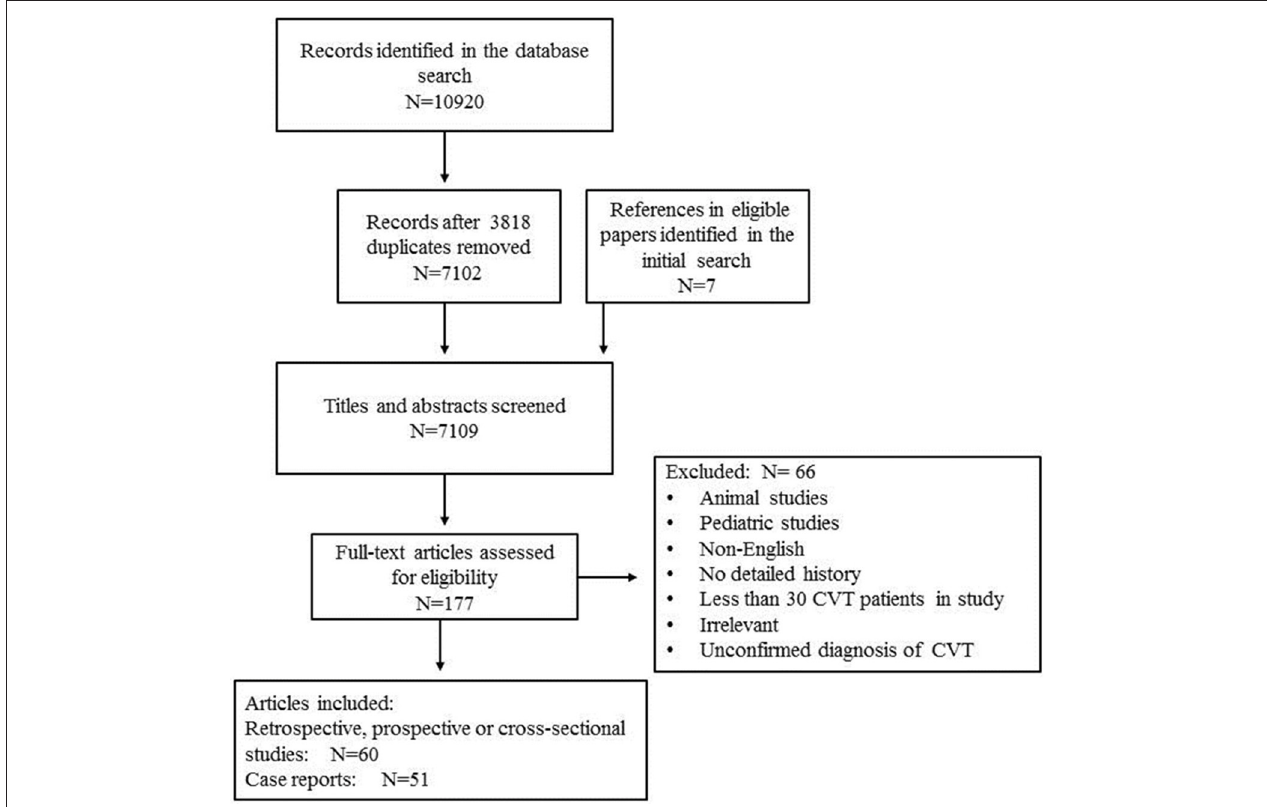
FIGURE 1 | Flowchart of the article search. N, number of